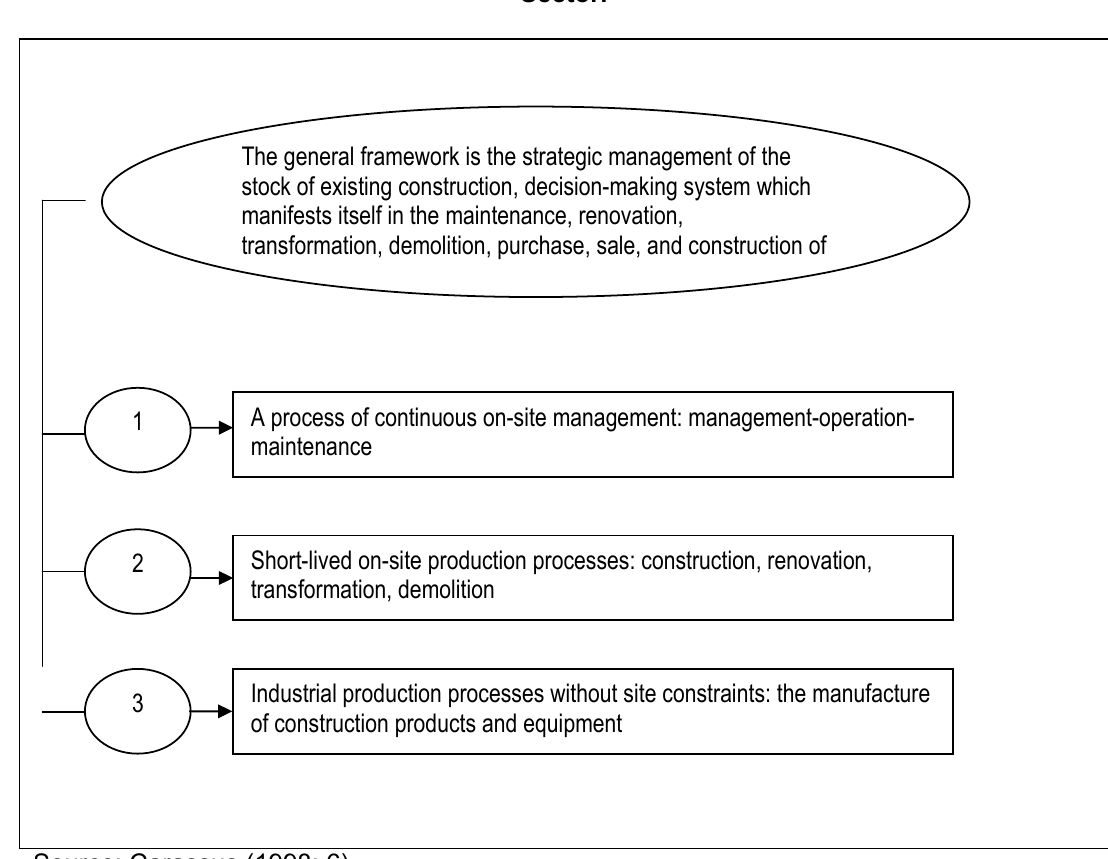
Figure 1. Three Types of Production-Management Processes in the Construction